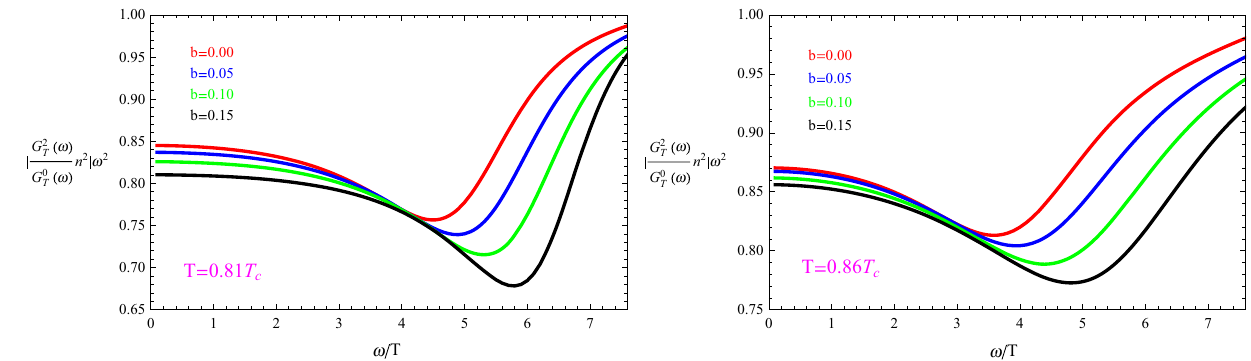
(ω) 2 T Fig. 5 | G n 2 | ω 2 as a function of ω/ T with the fixed temperatures G 0 T (ω) T = 0 . 81 T c (left) and T = 0 . 86 T c (right) for different values of the